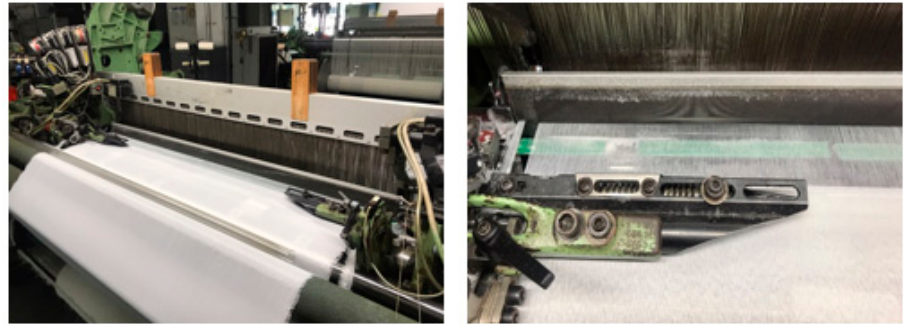
Figure 3. Process for fabrication of shielding fiber (rapier loom, Dornier, HTVS 8/S20). The intensity of radiation energy attenuates as it passes through the shielding fiber.